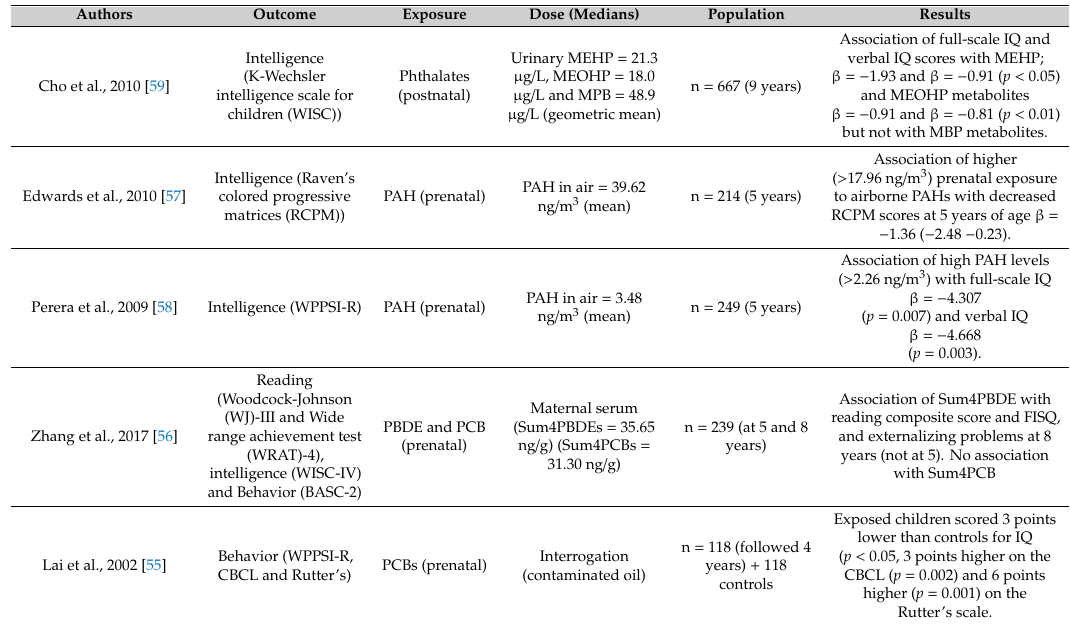
Table 4. Endocrine disruptors and intellectual disability.